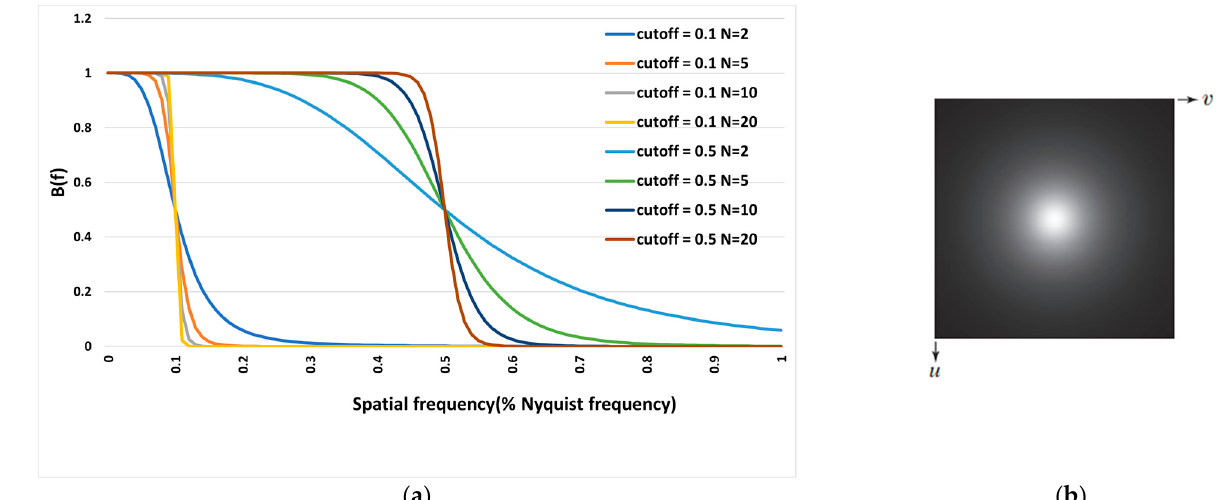
Figure 2. Diagram ( a ) of the Butterworth filter in terms of spatial frequency (Nyquist frequency percentage) and ( b ) the representation of the Butterworth filter function as an image.